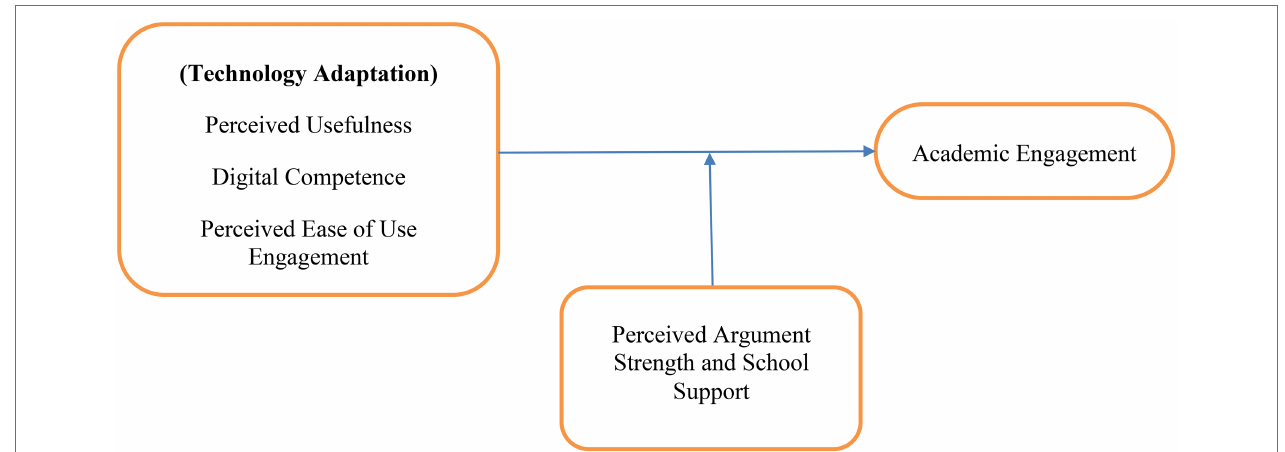
FIGURE 1 | Conceptual model of the